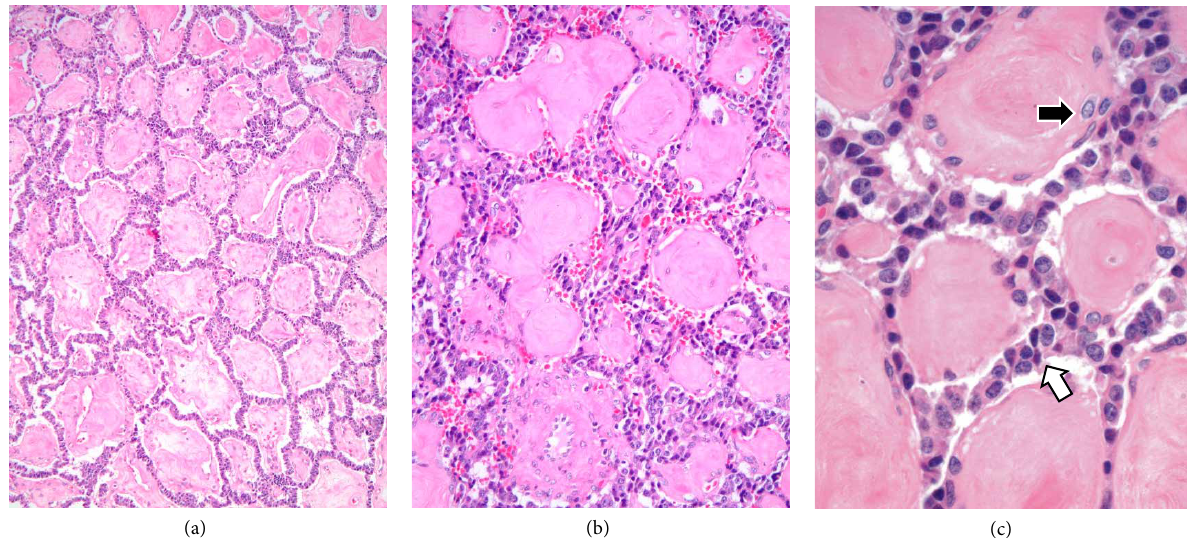
Figure 9: (a) Histologic sections from the pancreatectomy specimen confirmed a solid neoplasm with a low power pattern reminiscent of pulmonary alveolar edema or proteinosis with peripheral rims of epithelial cells surrounding eosinophilic spaces (Hematoxylin & eosin, 100X). (b) At greater magnification, the collagenized nature of the eosinophilic cobblestones is apparent with lesional epithelial cells in ribbons between the spheroids (Hematoxylin & eosin, 200X). (c) At highest magnification, the small, bland, tapering and spindled nuclei (black arrow) within the spheroids can be readily distinguished from the lesional epithelial cells between the cobblestones (white arrow) (Hematoxylin & eosin, 600X).